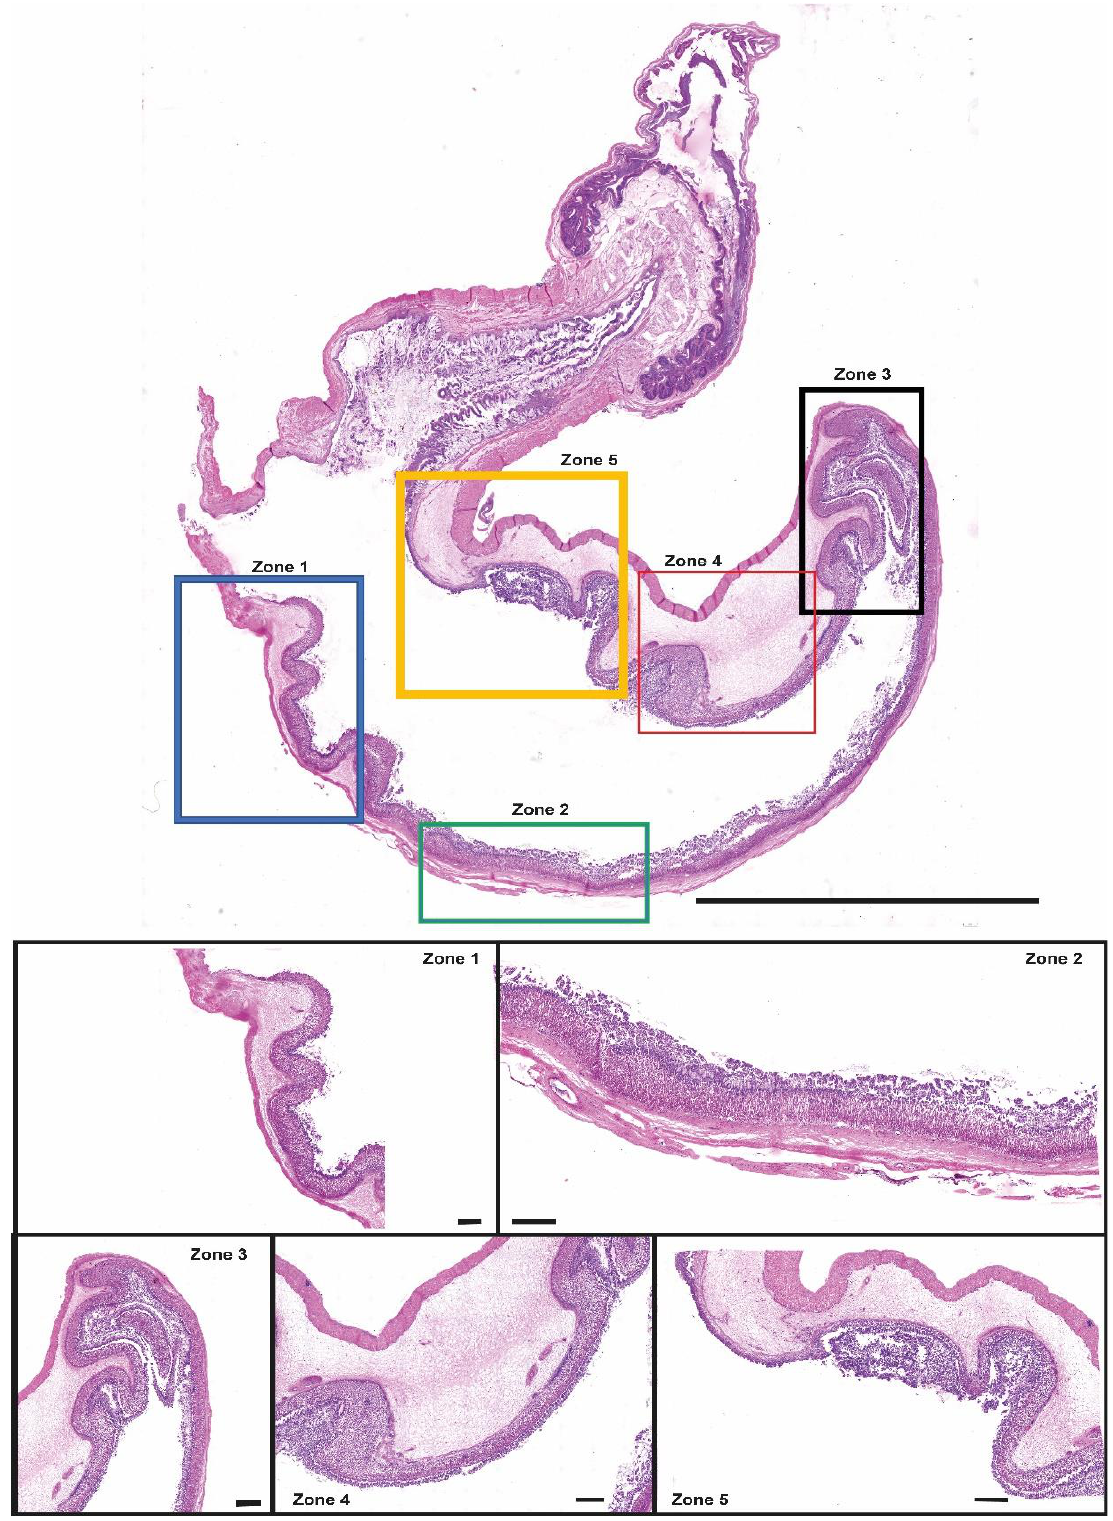
Figure 4. Morpho-functional organization of the stomach. Five zones based on morphological differences we highlighted: Zone 1: esophagus – gastric lumen passage, Zone 2: descending glandular portion, Zone 3: fundic portion, Zone 4: ascend- ing glandular portion, Zone 5: gastric-pyloric transition portion. Scale bars = complete reconstruction: 1 cm; Zone 1, Zone 2, Zone 3, Zone 4, Zone 5: 200um